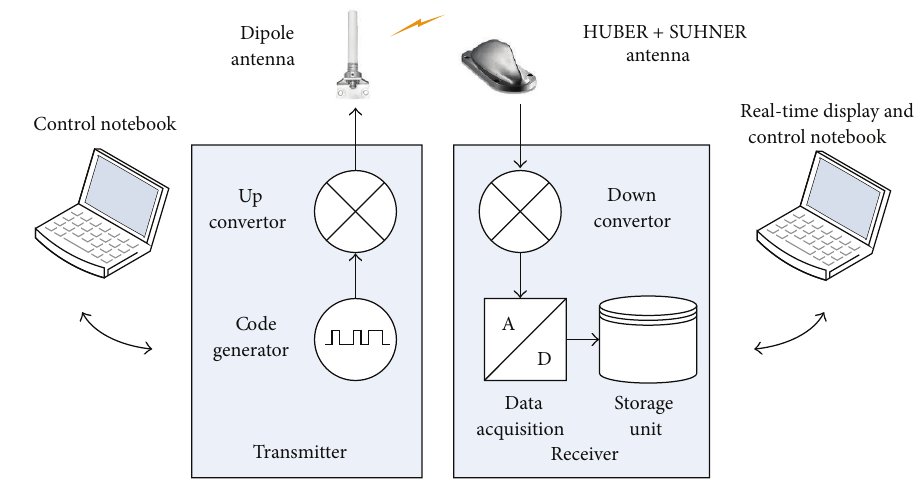
Figure 1: Propsound block schematic.